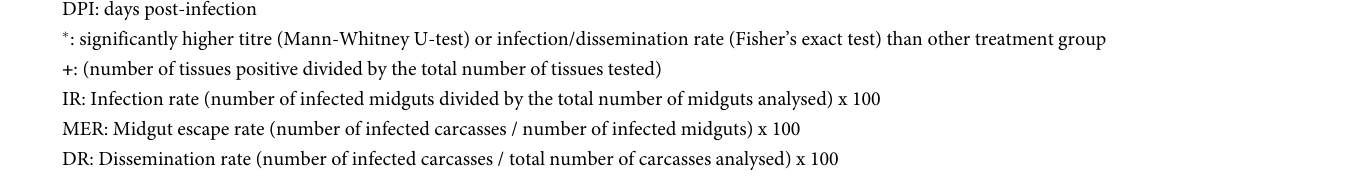
MG = Midgut � : 18 = number of measurements taken